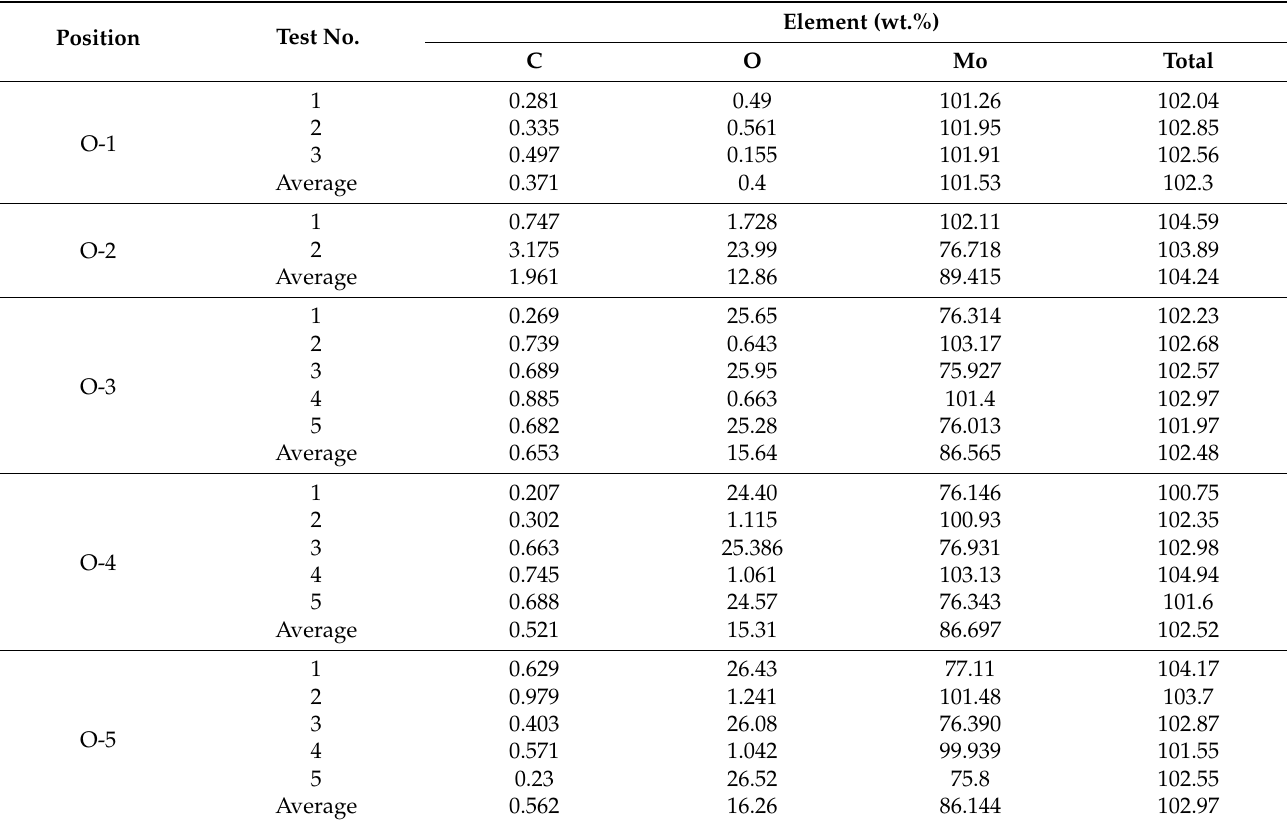
Table 3. Elements’ content measured in Figure